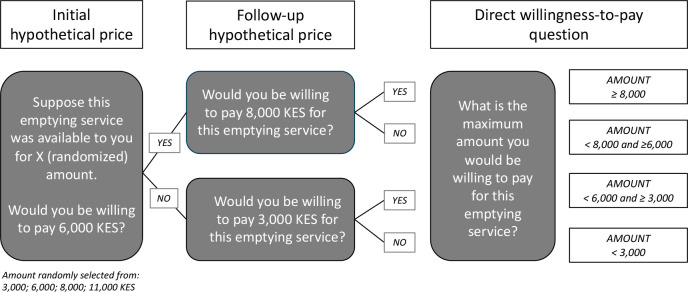
Sequence of willingness-to-pay questions.Using the double-bounded dichotomous choice method, we randomly asked households (i.e. landlords/homeowners and tenants) if they were willing to pay 3,000/6,000/8,000/11,000 KES (30/60/80/110 USD) for Gasia Poa emptying services. Depending on whether the respondent answered positively or negatively to the randomized amount, we then asked participants the same question for the next higher or lower amount. For example, if a respondent was willing-to-pay 6,000 KES (60 USD), we then asked if she was willing-to-pay 8,000 KES (80 USD), followed by an open-ended question about their maximum WTP. We used the same method to assess WTP for VTO emptying services with different starting price points.